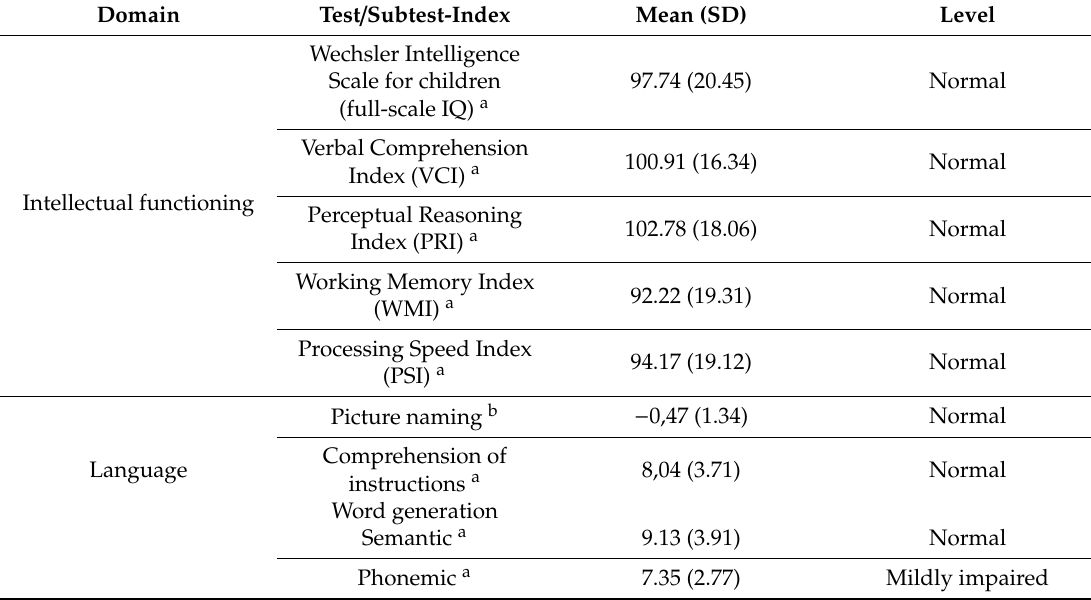
Table 1. Cognitive and neuropsychological test results in the 23 perspective evaluated